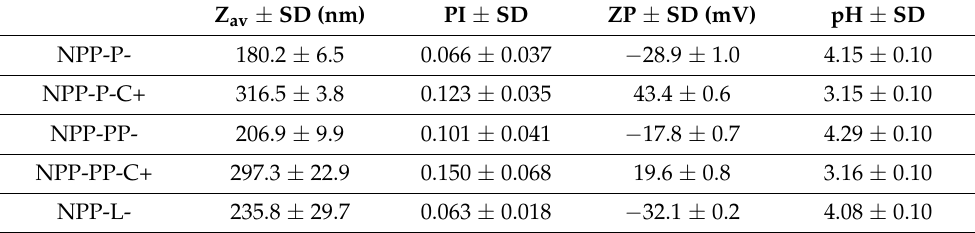
Table 1. Surface functionalized formulations of Thymol loaded PLGA NPs (TH-NP-L-: TH-NPs functionalized with phosphatidylcholine; TH-NP-P-: TH-NPs functionalized with Poloxamer 188; TH-NP-PP-: TH-NPs functionalized with Poloxamer 407; TH-NP-P-C+: TH-NPs functionalized with Poloxamer 188 and Chitosan; TH-NP-PP-C+: TH-NPs functionalized with Poloxamer 407 and